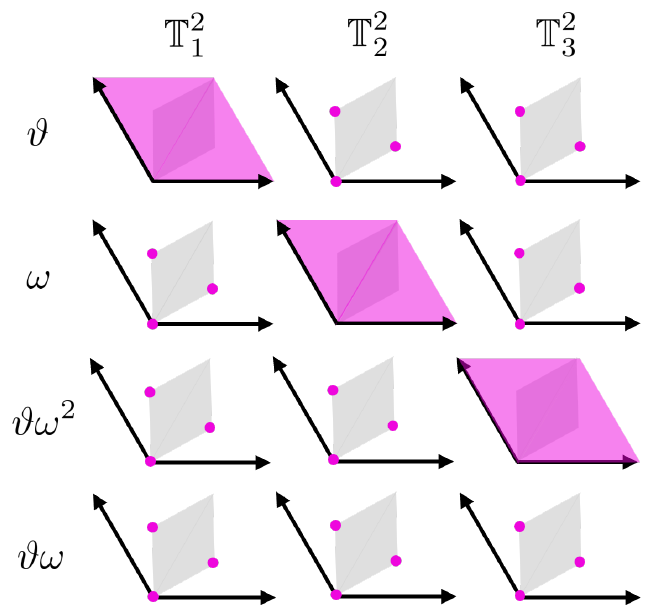
Figure 4 . This depicts the location of the fixed points (pink) of the orbifold ( T 2 × T 2 × T 2 ) / Z 3 × Z 1 − 1 grouped in sectors according to the group element that fixes them. The lattice Λ = 3 − SU(3) × SU(3) × SU(3) is depicted in terms of its generating vectors (black) and the fundamental domain of the orbifold is marked